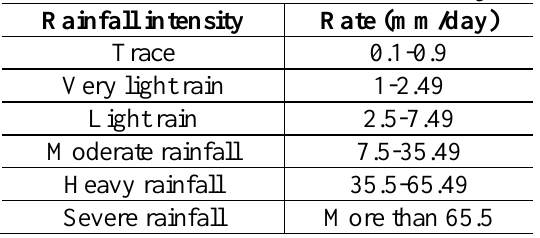
Table 1: Illustrates the rainfall